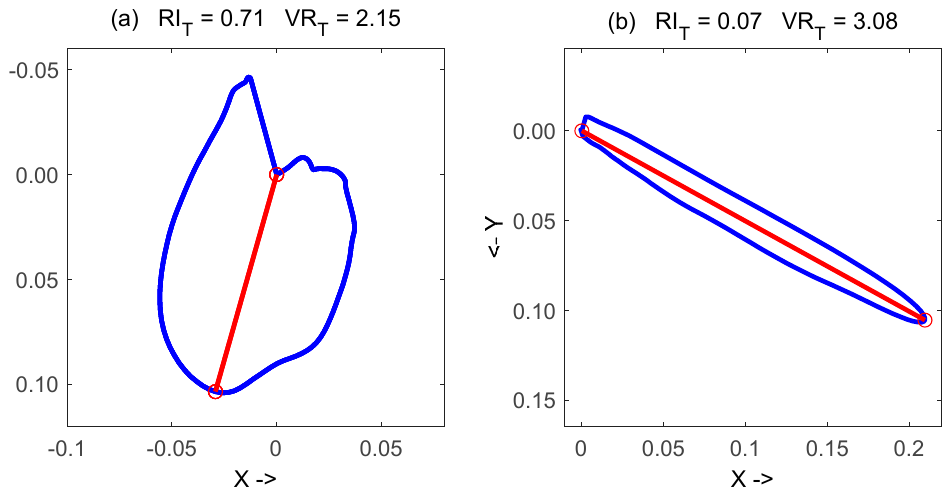
Figure 2. Roundness of T-loop, expressed by roundness index (RI T ) and T-vector_ratio (VR T ) in a male patient with myocardial infarction and congestive heart failure ( a ) and in healthy male ( b ).